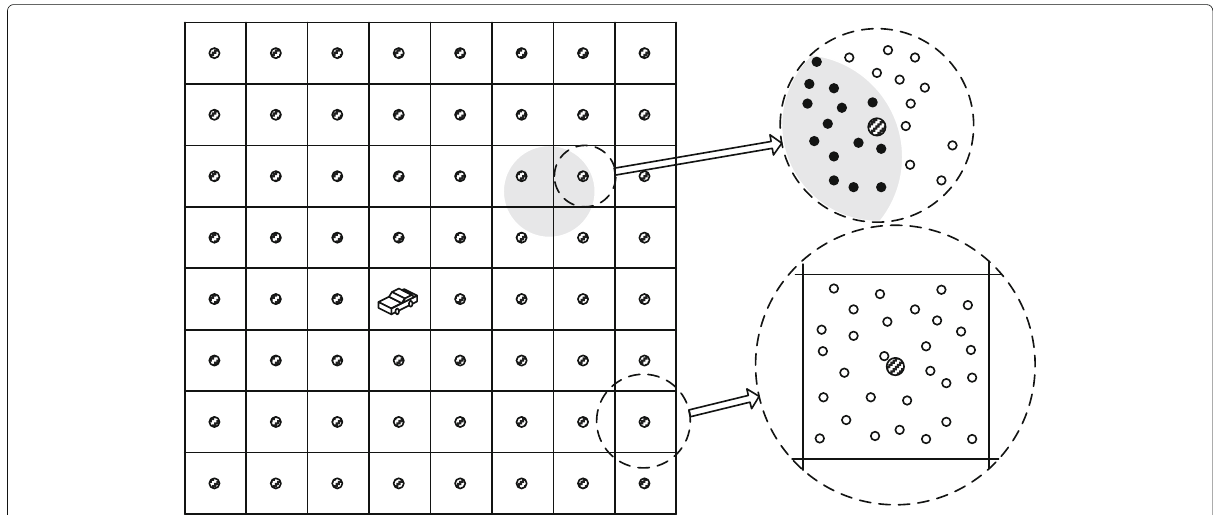
Fig.1 Source nodeslocatedinalocalregionwithemergingevent.Thegraycircle